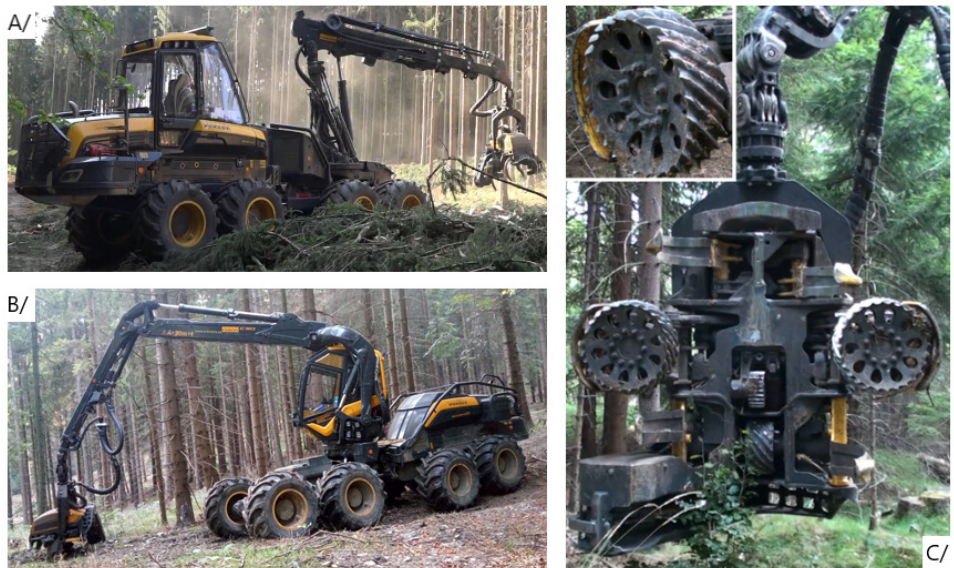
Figure 2. ( A ) Ponsse Ergo 8 W harvester; ( B ) Ponsse Scorpion King harvester; ( C ) Modifications of the H7 harvester head.